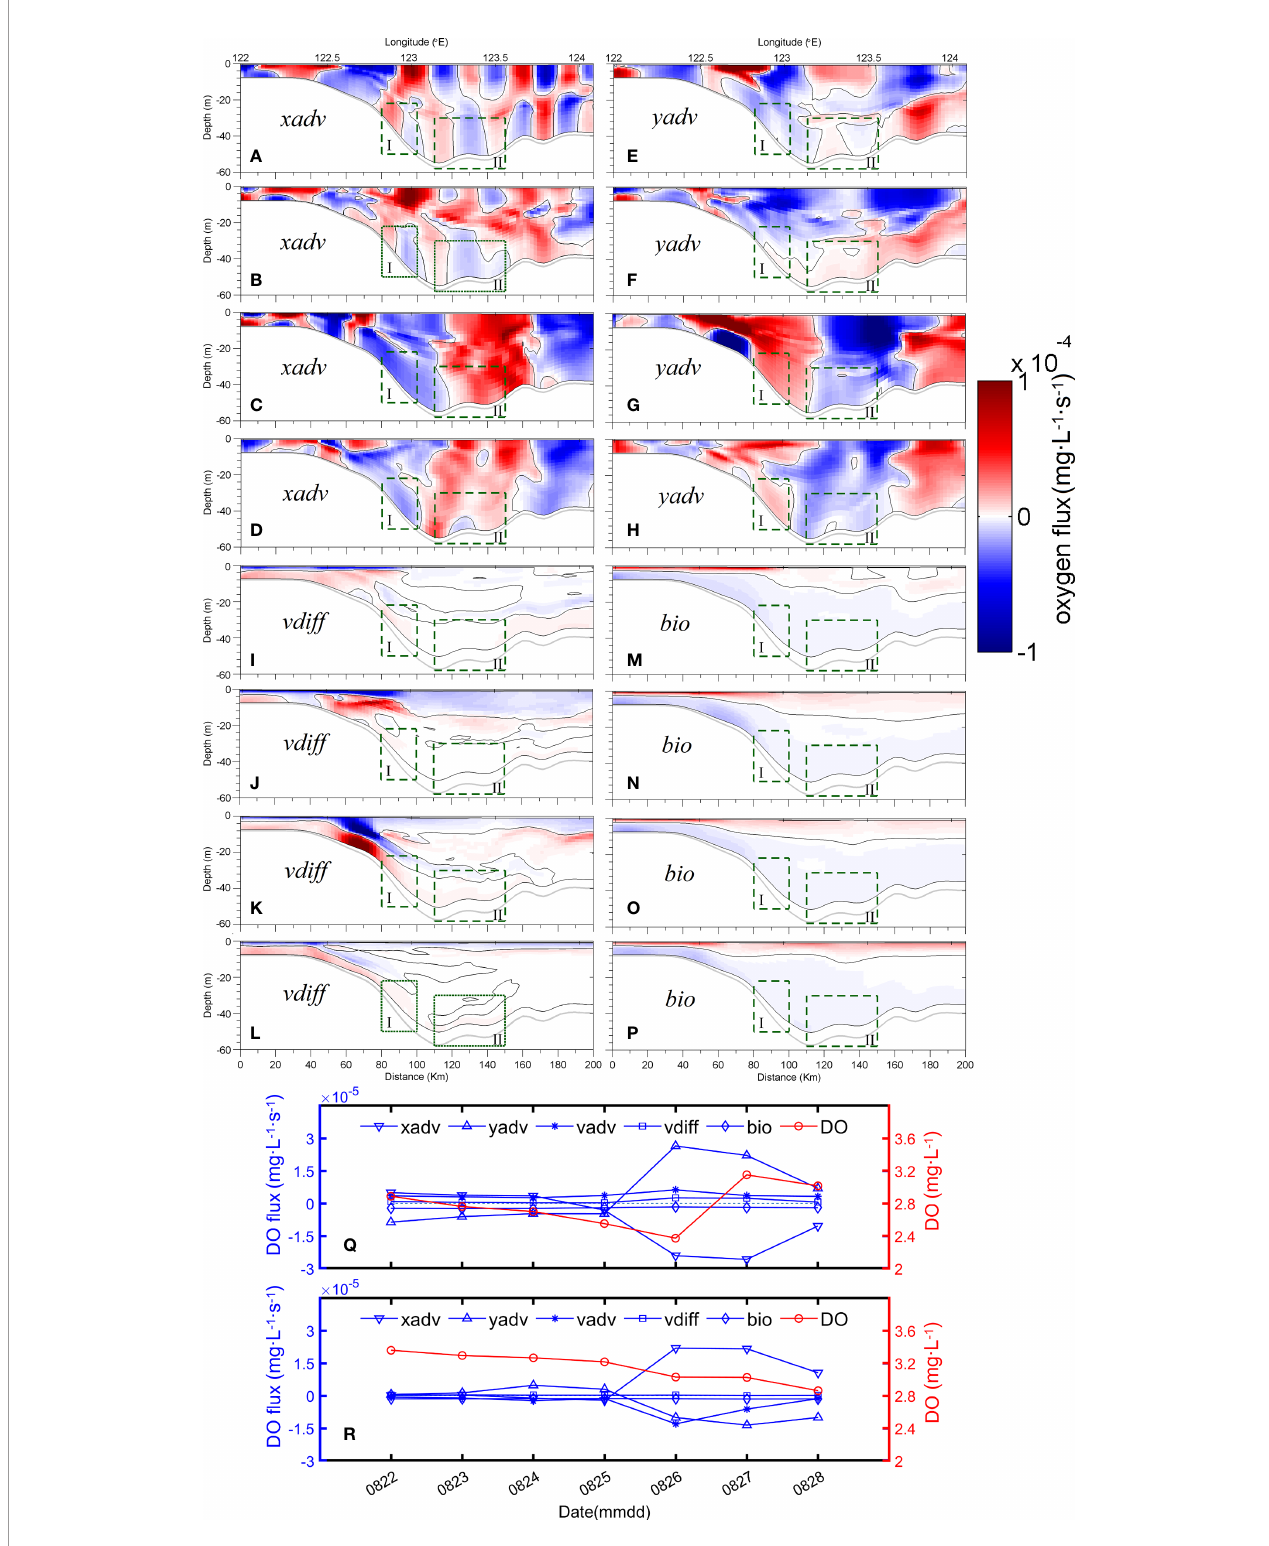
FIGURE 13 | The diagnostic terms for xadv , yadv , vdiff , and bio in terms of dissolved oxygen (DO) at the 31°N transect on August 22 (A – D) , 25 (E – H) , 26 (I – L) , and 28 (M – P) , 2020. Regions I and II are marked by dashed rectangles in (A – P) . (Q, R) are time series of diagnostic terms in terms of DO averaged in Regions I and II,